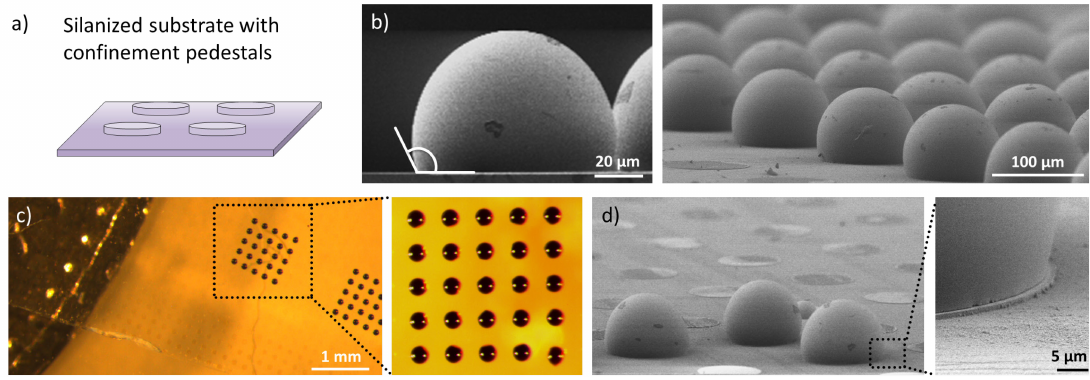
Figure 4. Printed SPMPC spherical structures on confining pedestals ( a ) substrate scheme and ( b ) side view SEM image showing edge angles of 112° ± 4°. ( c ) Top view optical image of a 5 by 5 array printed on pedestals next to a 10-cents Swiss coin and inset of the array, showing the well aligned microstructures. ( d ) SEM side view image showing three isolated spherical structures and zoom into one confinement pedestal with the printed structure; this specific example has a height of 850 nm, but the average height has been measured at 1.0 ± 0.1